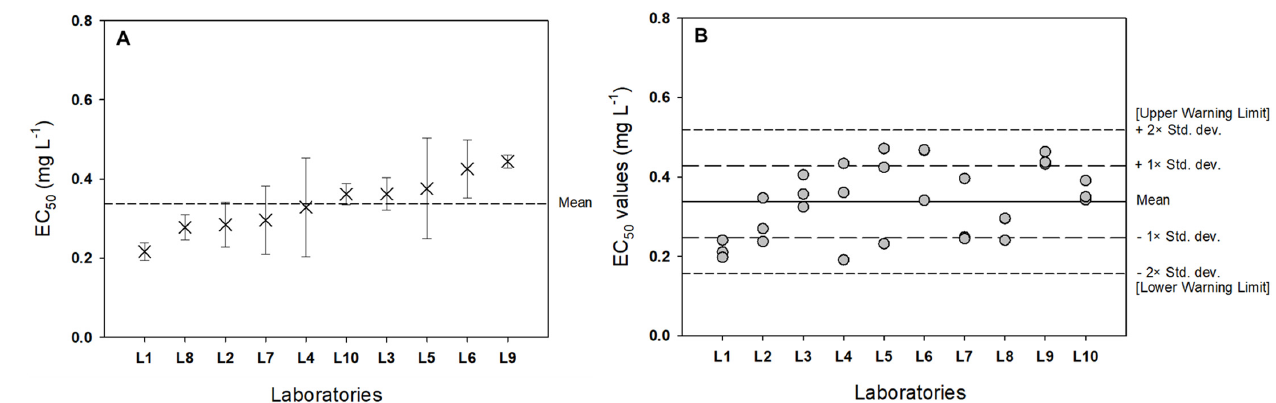
Figure 4. ( A ) Mean regrown EC 50 ± standard deviation from 10 laboratories. ( B ) Graphical representation of the warning chart approach.